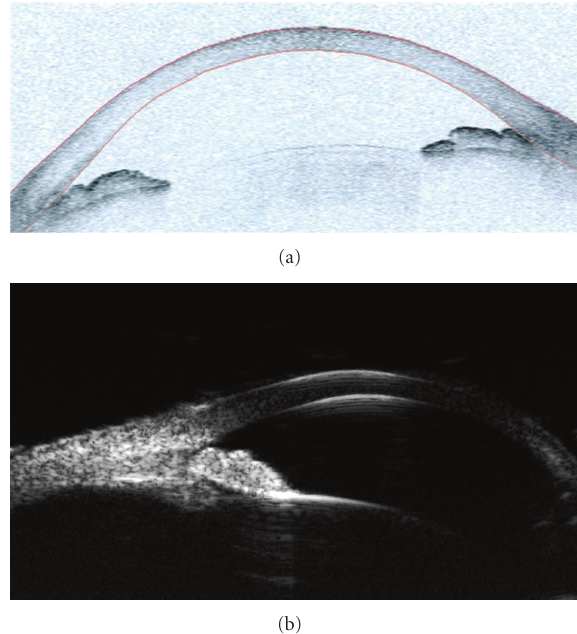
Figure 6: AS-OCT and UBM (ultrasound biomicroscopy) images in an eye with plateau iris syndrome. AS-OCT (a) shows closed angle in anterior segment single-mode image, but is limited in visualization of pathology posterior to the iris. UBM (b) shows anterior rotation of the ciliary body and assists in the diagnosis of plateau iris